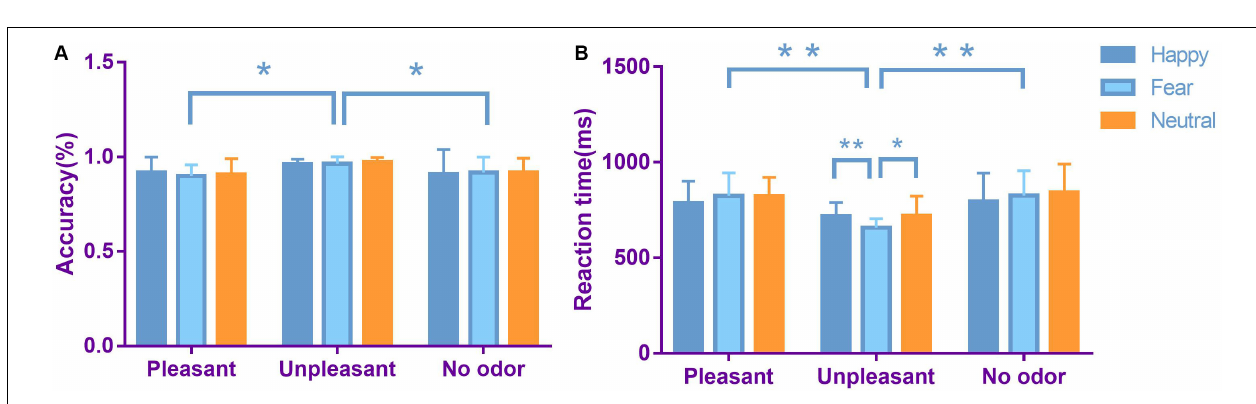
Frontiers in Neuroscience |